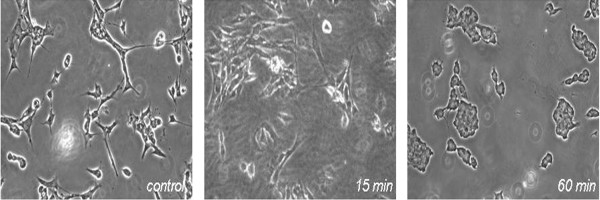
Morphologic changes following exposure to ICG dye. Representative images at 0.5 mg/ml concentration were obtained with phase contrast microscopy. Cells became rounder and smaller with increasing duration of exposure.